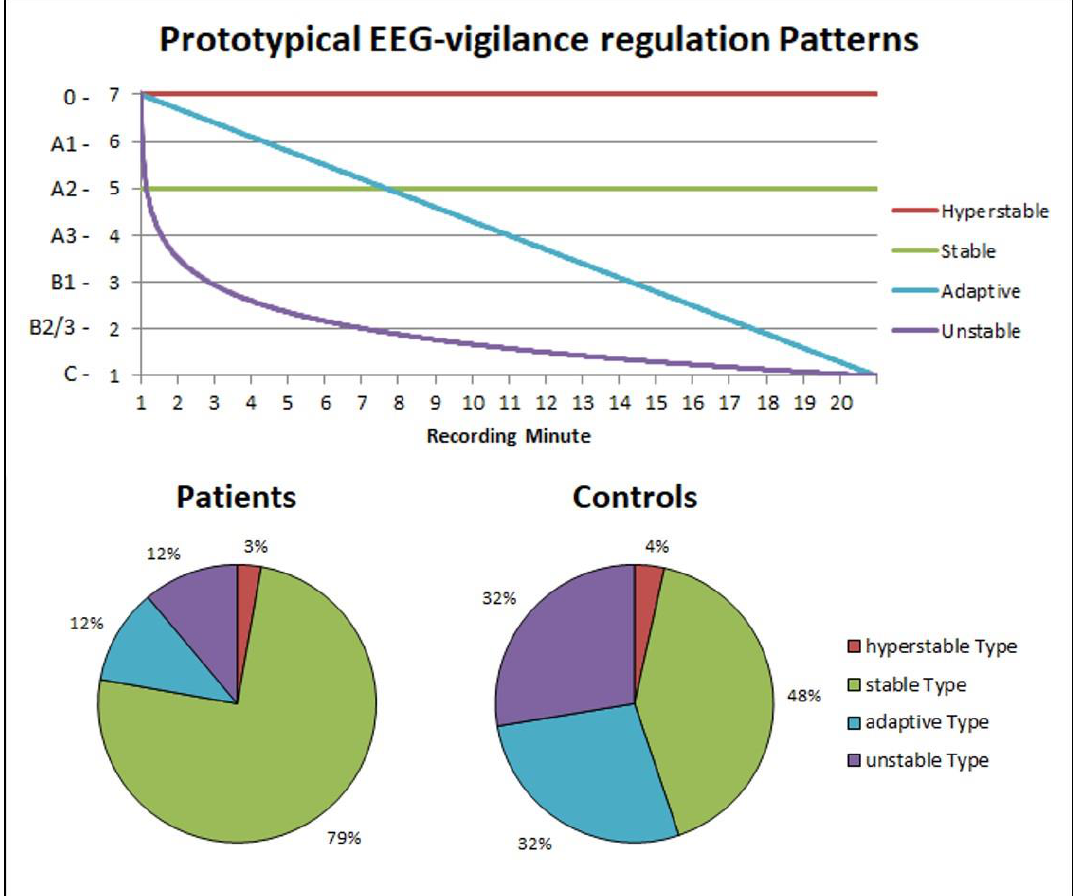
Figure 3. Frequency of prototypical vigilance regulation time courses. Differential distribution of prototypes: chi-square test; p = 0.044 (one-tailed).